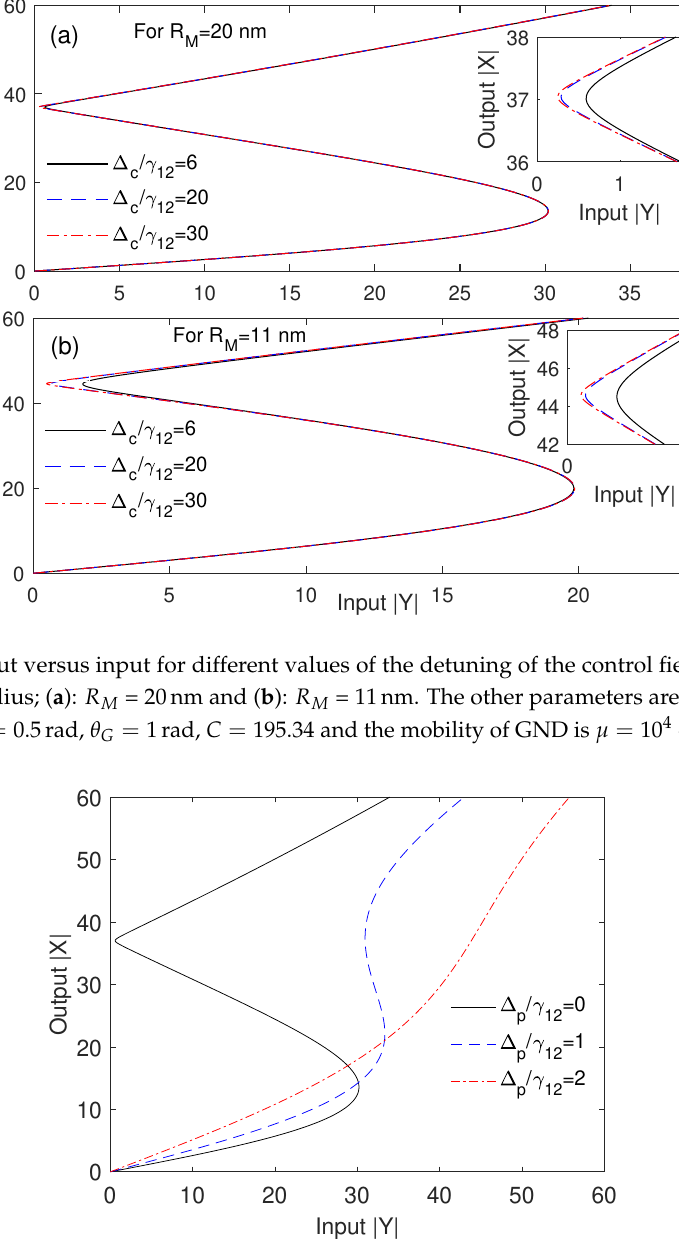
= 0.5rad, θ = 1rad, C = 195.34 and the M G